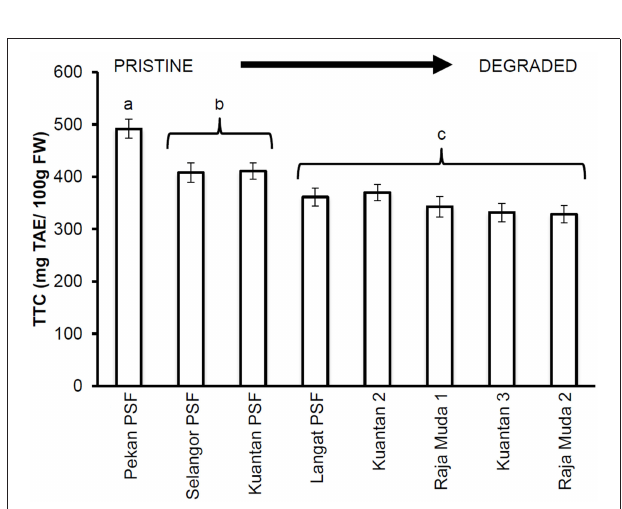
FIGURE 3 | Mean ( ± 1 SD ) total tannins in mature leaves of M. pruinosa at each peatland ( n = 45 except Pekan PSF, n = 15). Values followed by the same letter (a–c) are not significantly different at P < 0.05 as measured by the Tukey HSD test.